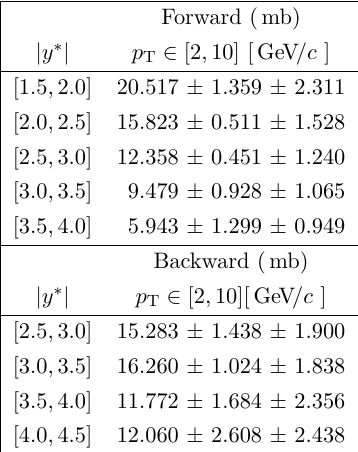
baryons as a function of j y (cid:3) j in p Pb c